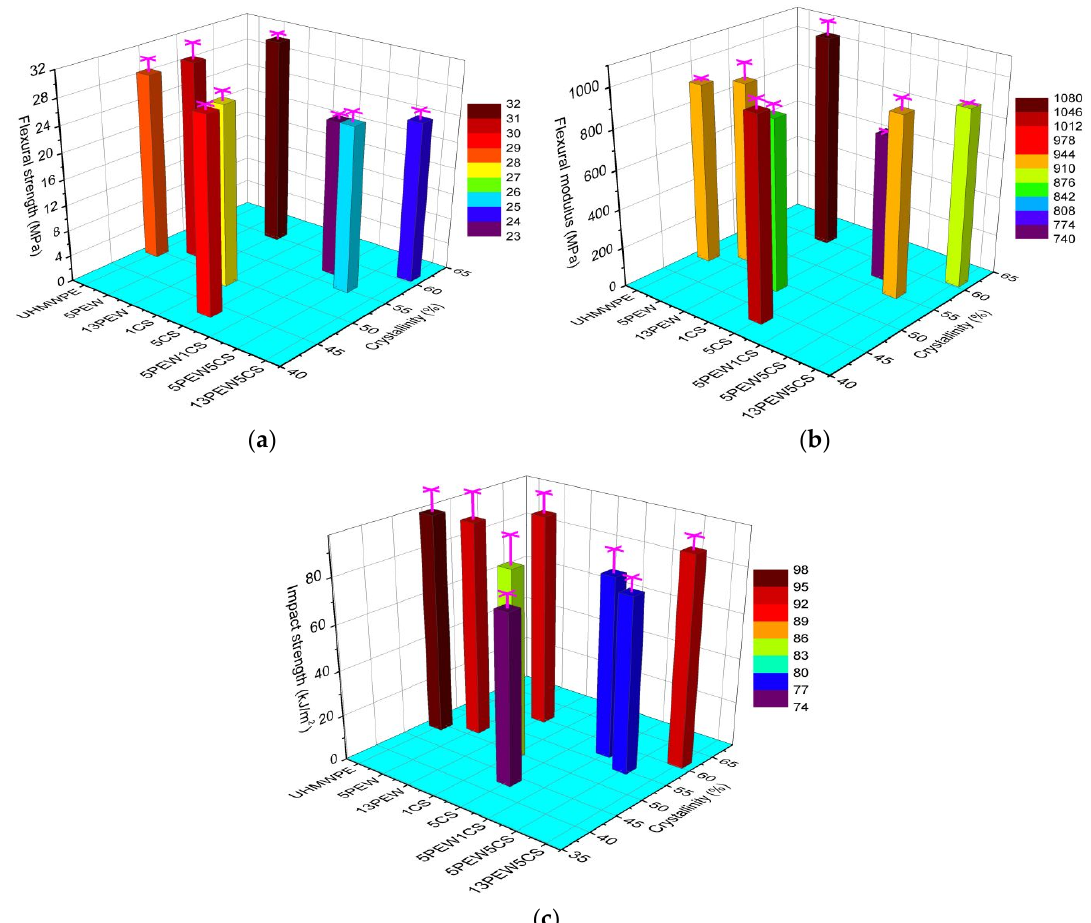
Figure 8. Mechanical properties of the samples: ( a ) flexural strength; ( b ) flexural modulus; ( c ) notched impact strength.